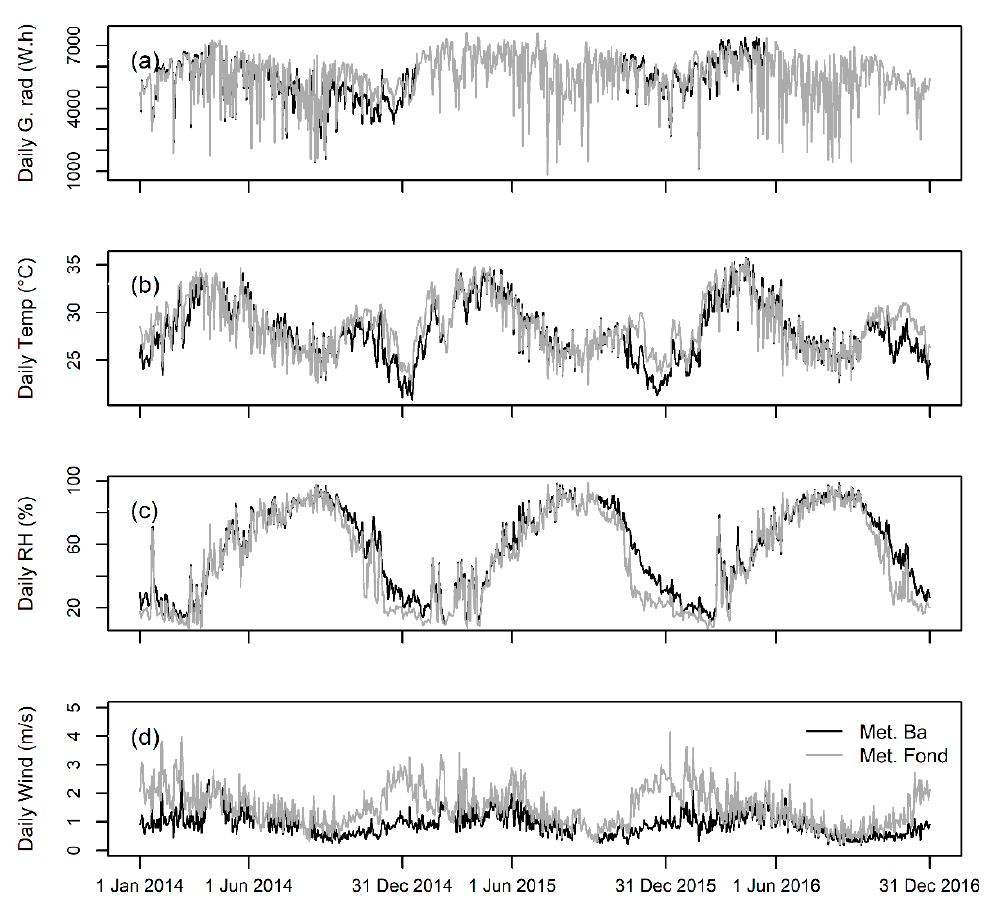
Figure 5. Daily mean of the observed ( a ) global radiation (G. rad), ( b ) air temperature at 2 m height (Temp), ( c ) relative humidity (RH), and ( d ) wind speed at the two weather stations Met. Ba and Met. Fond from 2014 to 2016 (see Figure 1 for the locations of the weather stations).